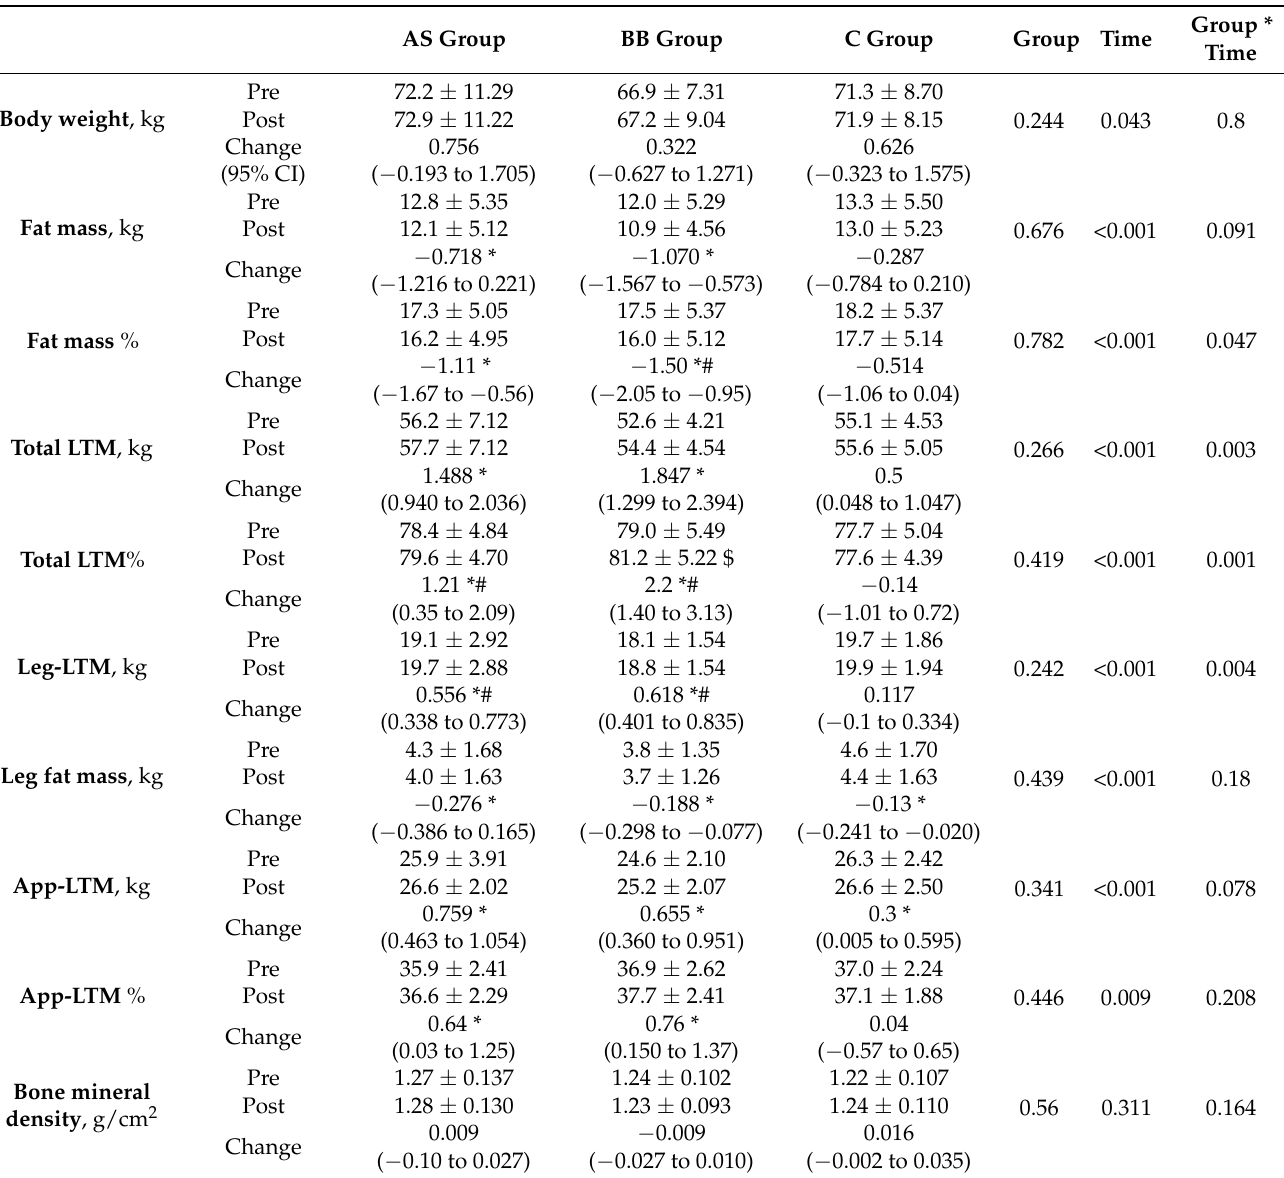
Table 4. Changes in body